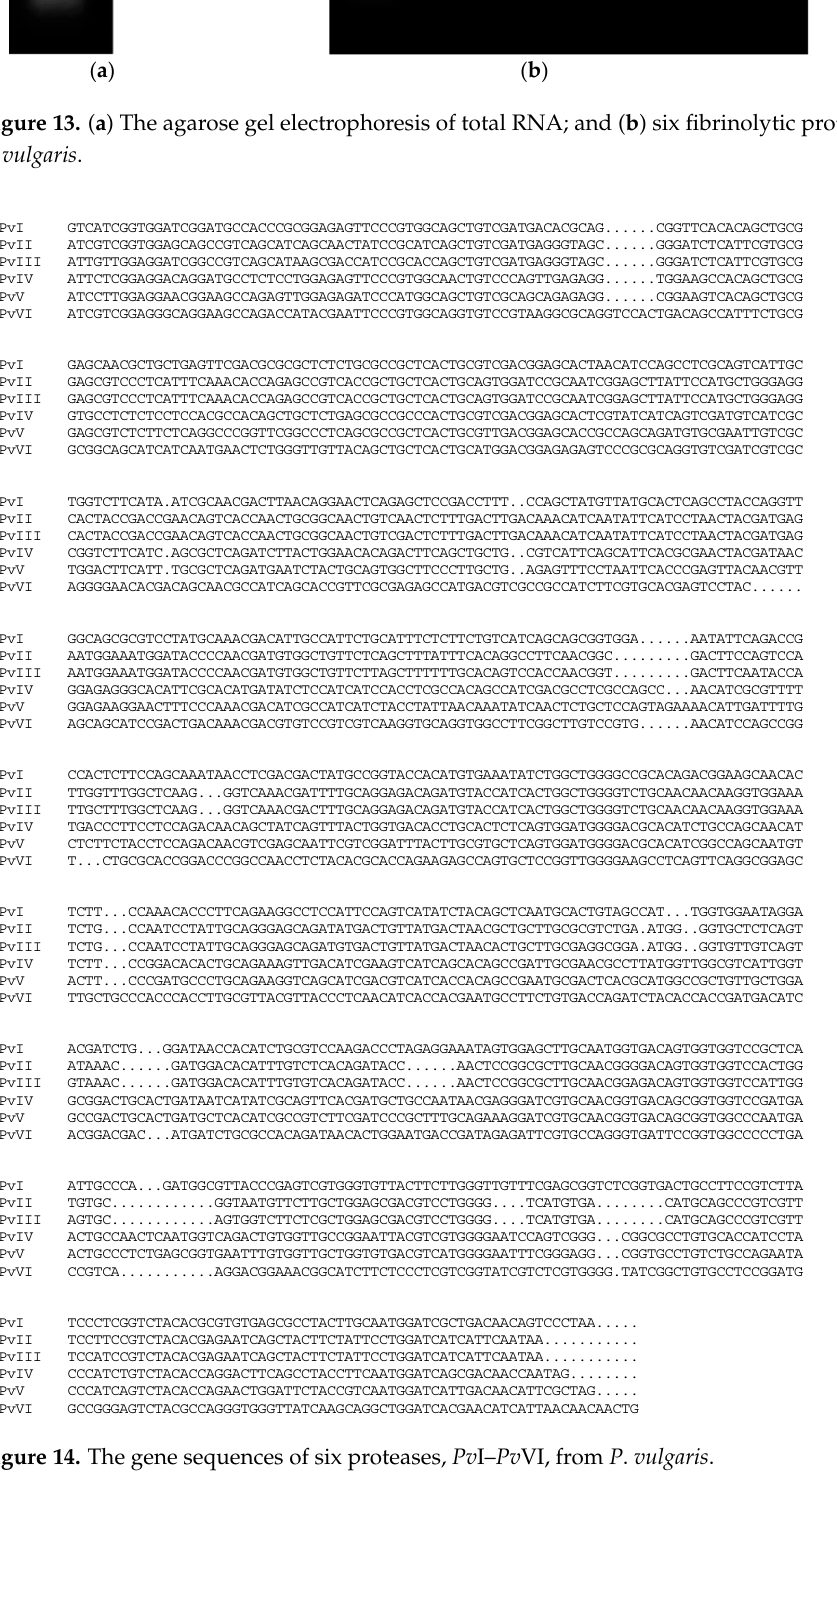
Figure 13. ( a ) The agarose gel electrophoresis of total RNA; and ( b ) six fibrinolytic protein genes of P. vulgaris . Molecules 2021 , 26 , x FOR PEER REVIEW